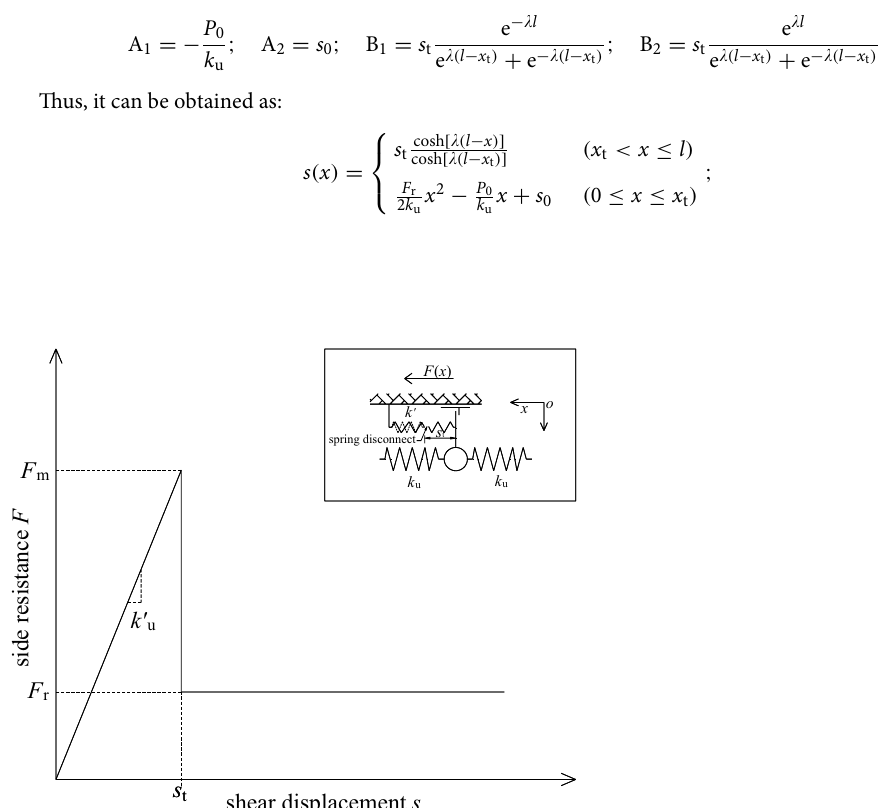
Figure 14. Schematic diagram of modified spring